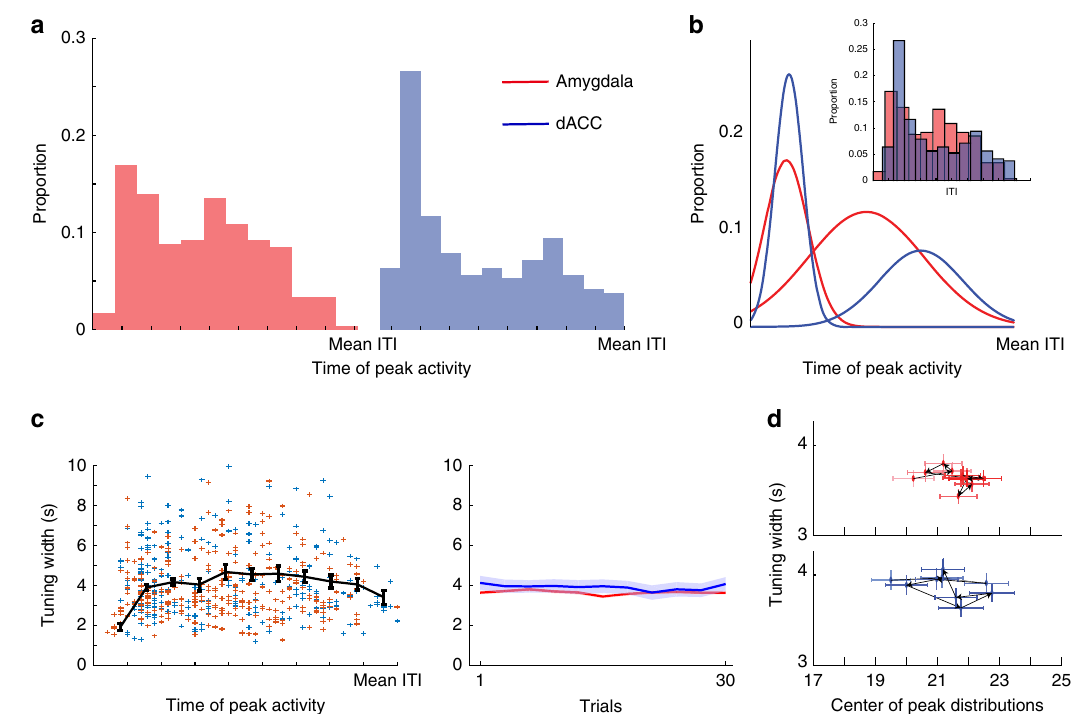
Fig. 6 Peak activity during the ITI is differentially distributed. a Histograms of the locations of single-unit peak activity for both regions. b Fitted gaussians for the histograms shown in a ; inset shows the two distributions overlaid. Amygdala: SSE = 0.0025, r 2 = 0.8111 and SSE = 0.0011, r 2 = 0.9238; dACC: SSE = 0.0152, r 2 = 0.5695 and SSE = 5.3466e-04, r 2 = 0.7565. c Left: tuning width of individual cells plotted against the time of peak activity for amygdala (red) and dACC (blue) cells, with mean ± S.E.M. (black). Middle: the average width did not change during acquisition (one-way ANOVA; amygdala: df = 10, f = 1.2, p > 0.28; dACC: df = 10, f = 1.78, p > 0.059; t -test for between-area difference, p > 0.07). d Mean tuning-width (from c ) against mean peak location (from a ) for all cells, shown for bins of fi ve trials during acquisition (one-way ANOVA; amygdala: df = 10, f = 0.96, p > 0.46; dACC: df = 10, f = 1.58, p > 0.1; t -test for between-area difference, p < 0.001). Both parameters showed stability during learning. Single units: amygdala: n = 101; dACC: n =